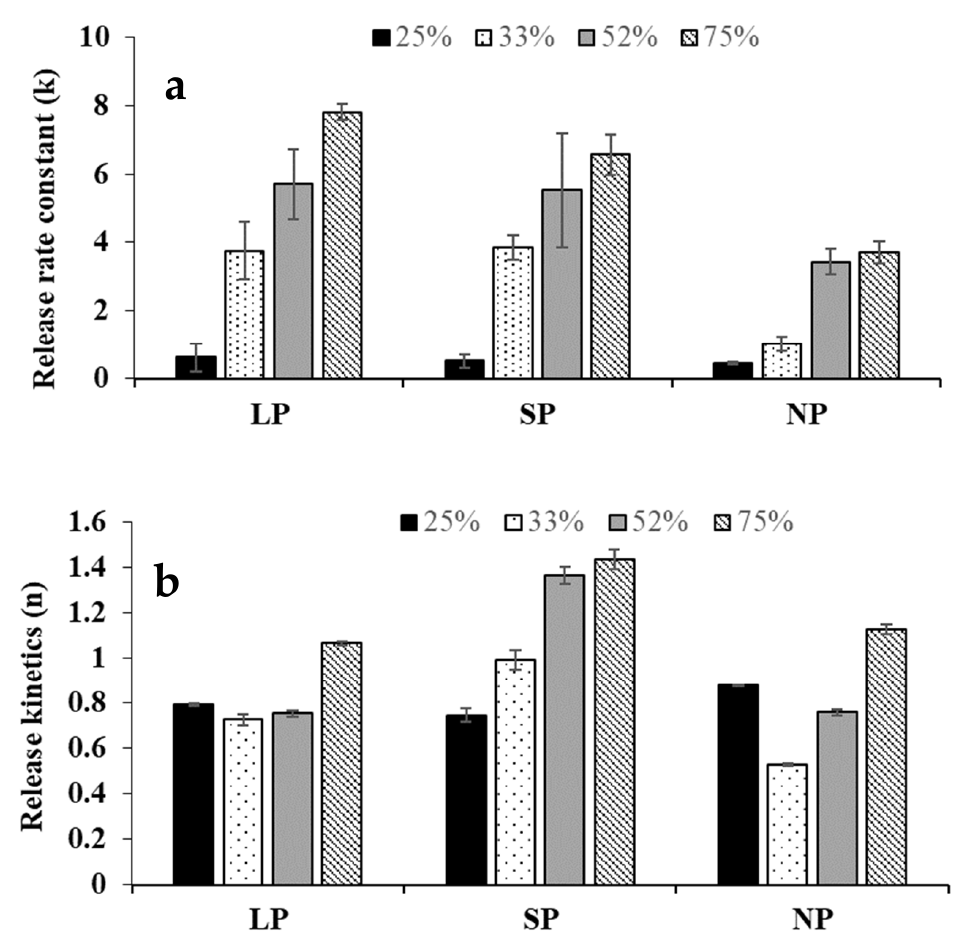
Scheme 1. Effect of particle size on the parameters of the Avrami equation for the spray-dried